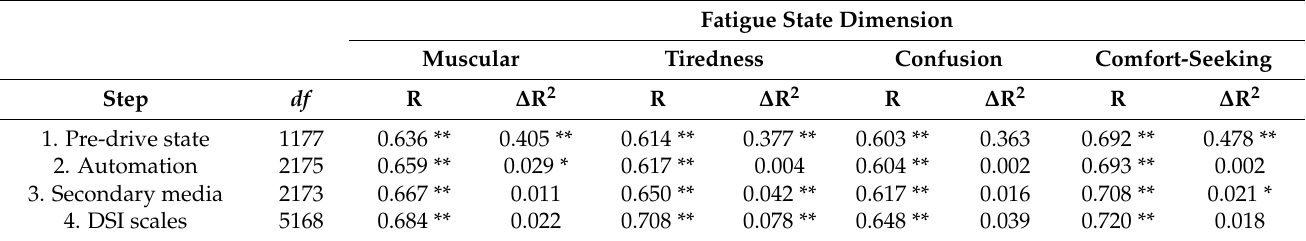
Table 4. Summary statistics for regressions of four fatigue state dimensions on pre-task state, experi- mental factors and DSI